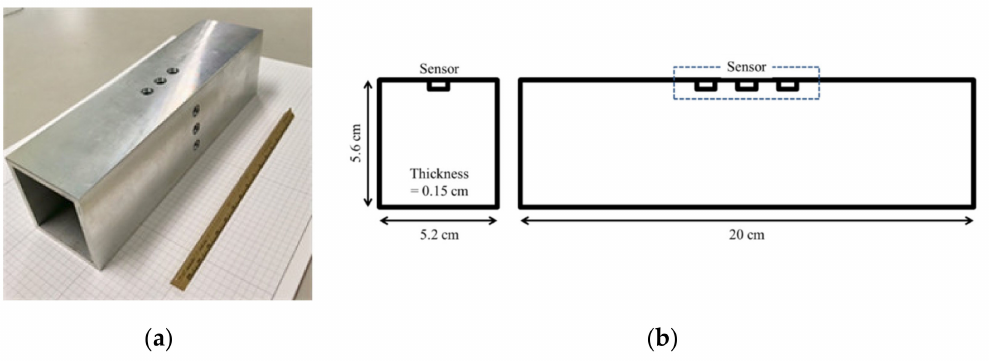
Figure 3. Specimens of scaled box culverts used in centrifuge model test: ( a ) specimen and ( b ) location of sensors for measuring vertical earth